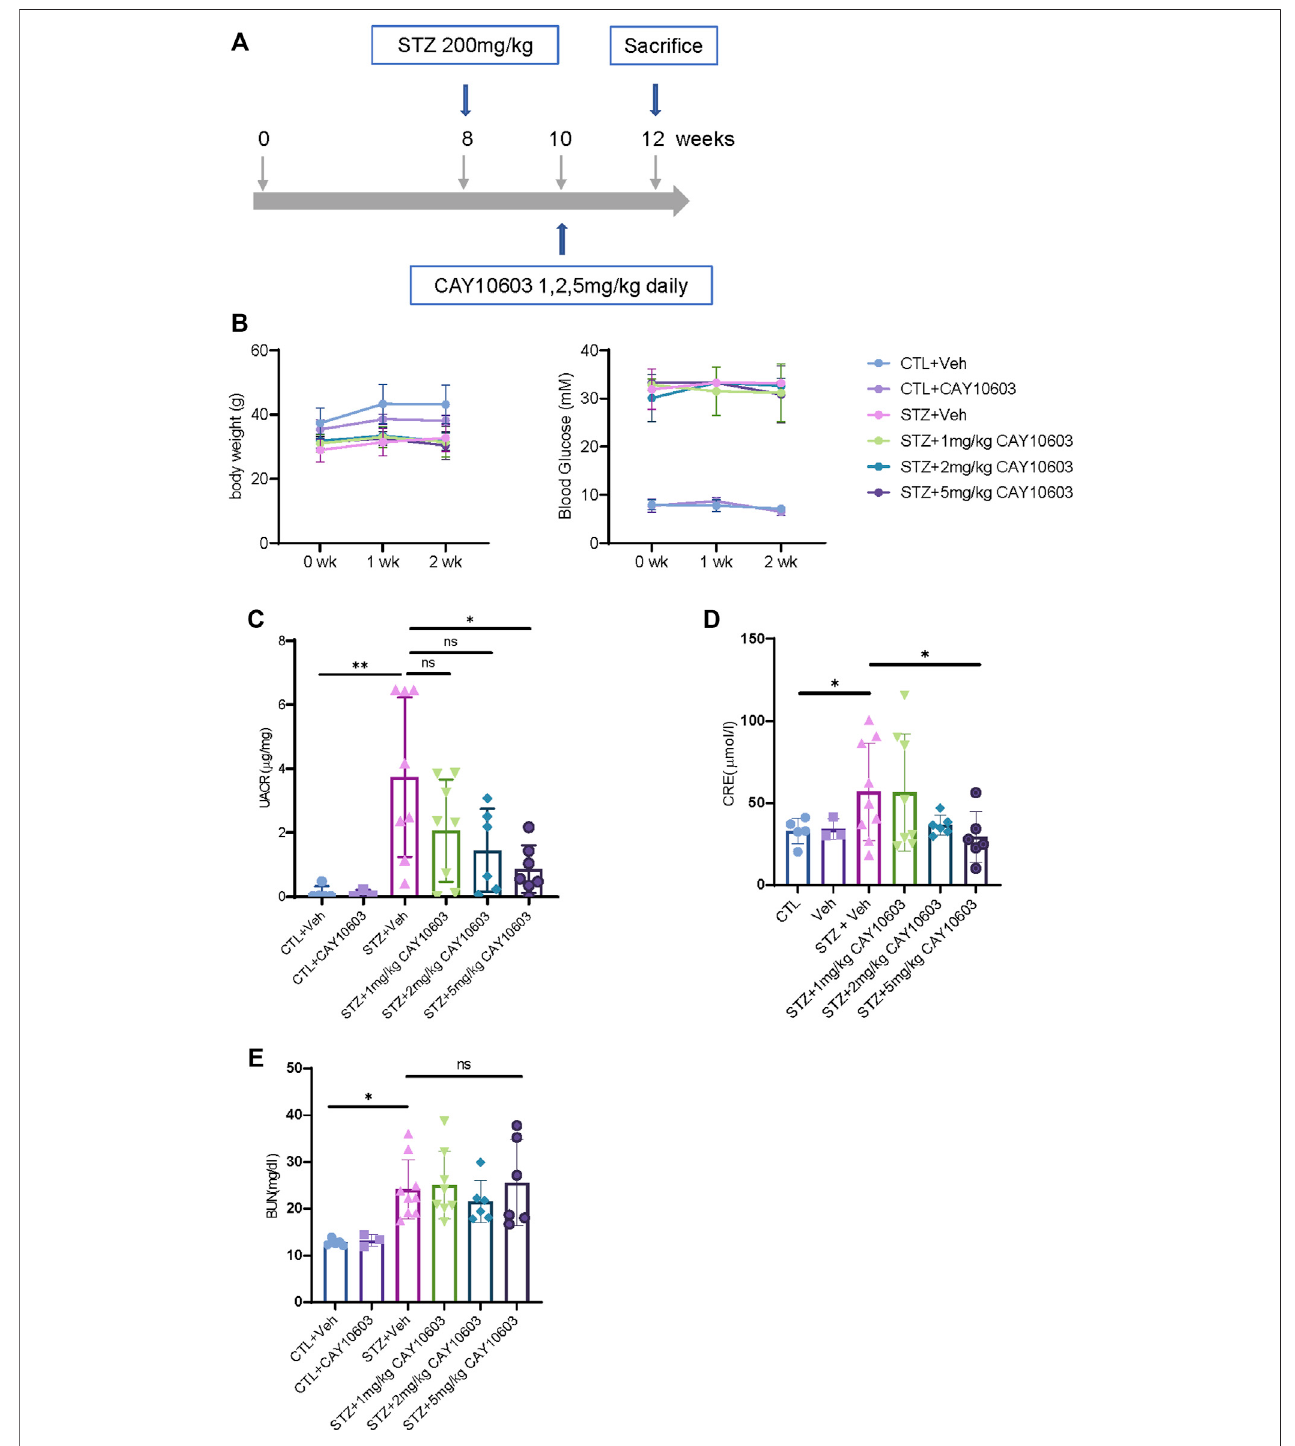
FIGURE 3 | CAY10603 improves kidney function in the early stage of diabetic mice. (A) Schematic diagram of experiment design. (B) body weight and blood glucose in different groups and time point as indicated. (C) Urine albumin to creatinine ratio in different groups as indicated. (D) Serum creatinine and (E) serum BUN in different groups as indicated. * p < 0.05; ** p < 0.01. Two-way ANOVA.